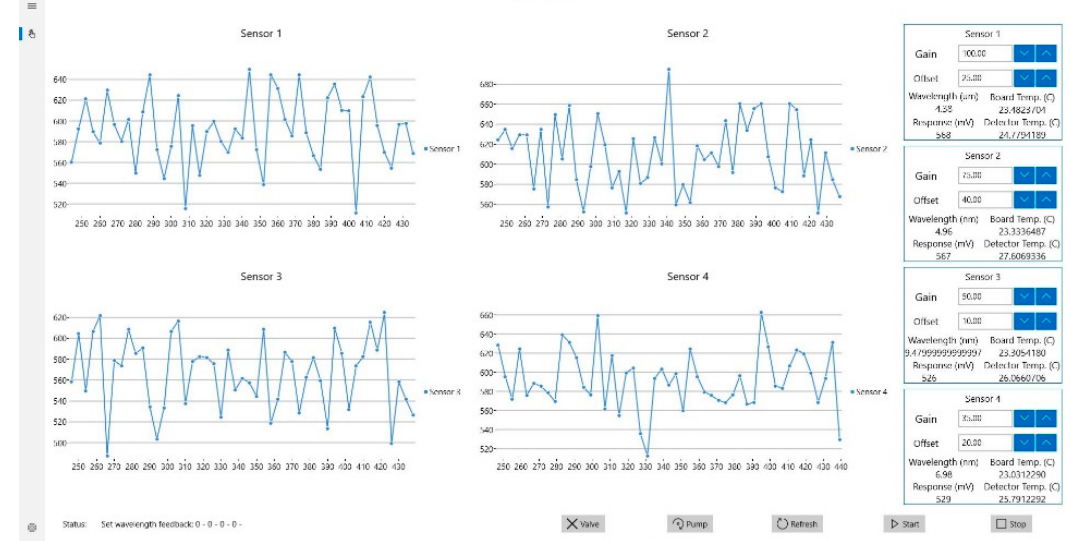
Figure 8. Optical electronic nose graphical user interface.